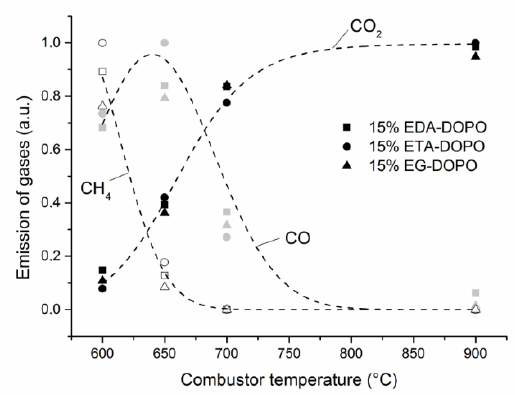
Figure 3. Emission of CO 2 , CO, and CH 4 versus combustor temperature.